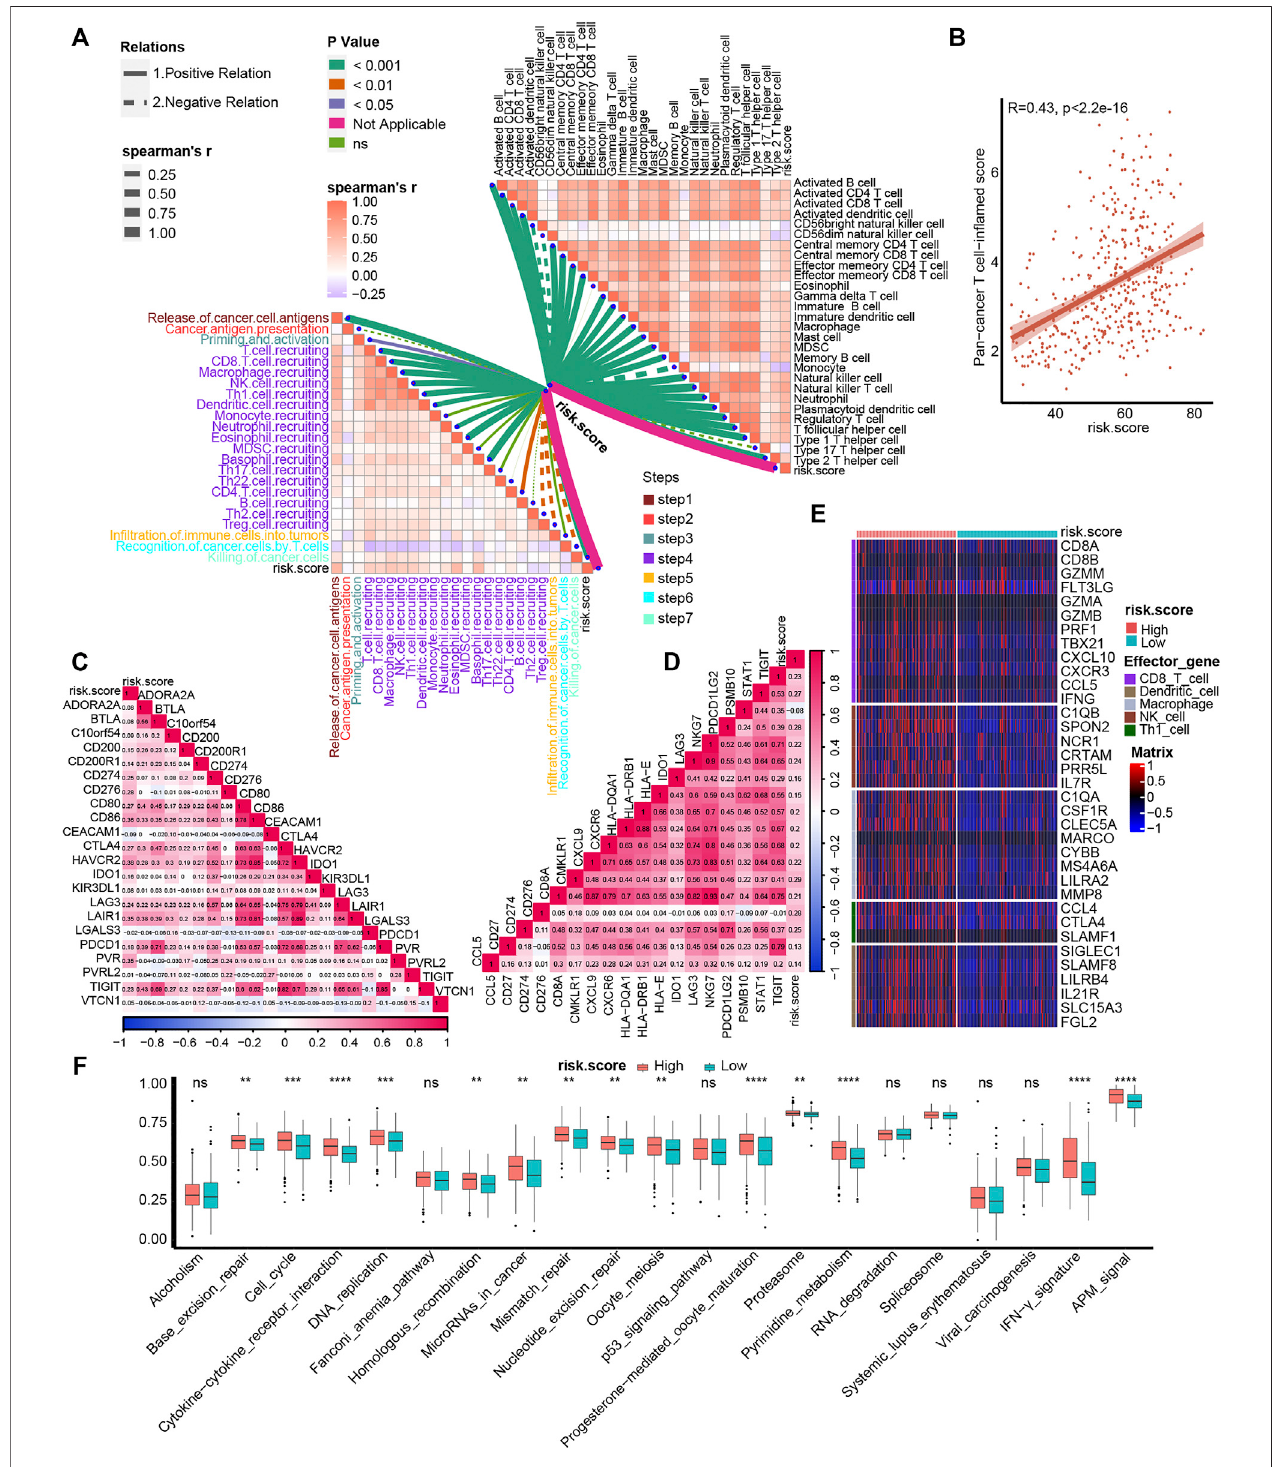
FIGURE 4 | Association between TNF family – based risk score and TIME and ICB response. (A) The association between TNF-based risk score and cancer- immunity cycles (left) and immune cells in the TME (right) . The different types of lines represent the positive or negative relations. The different colors of the lines represent the p values of the relations, and the thickness of the lines represents the strength of the relations. (B) The association between TNF-based risk score and T cell – associated in fl ammatory signature (TIS) score. (C , D) The association between TNF-based risk score and immune checkpoint inhibitor (ICI) genes and TIS genes, respectively. (E) The different expression patterns of effector genes of immune cells between different TNF-based risk score groups. (F) The different activated levels of gene signatures associated with ICB response between different TNF-based risk score groups. Red and azure lines represent high and low TNF-based risk score, respectively. ** p < 0.01, *** p < 0.001, **** p < 0.0001; ns, not statistically signi fi cant.